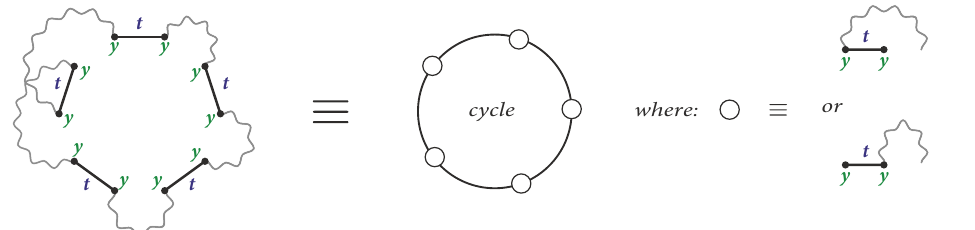
Figure 3: A generic closed chain in class A embedded in the plane can be seen as a cycle built out of two kinds of blocks, each of type Y 2 T , arising from different choices of X ’s attached to the same T by the derivative on either the left or right (hence possible crossings of the wavy lines).